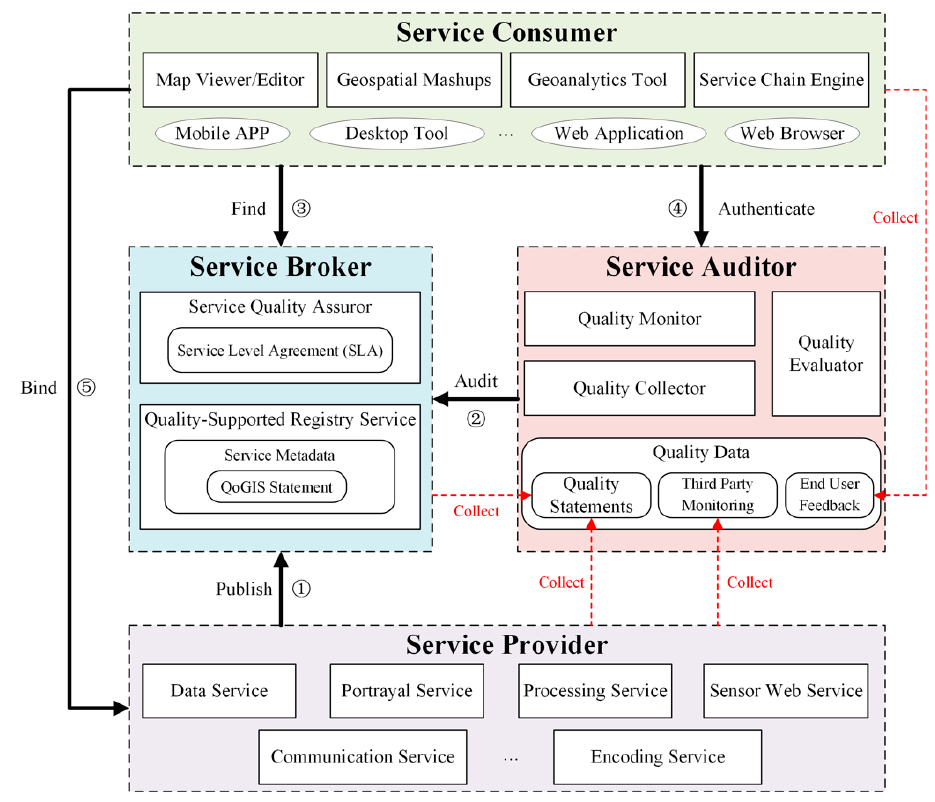
Figure 7. QoGIS-aware GIService framework.